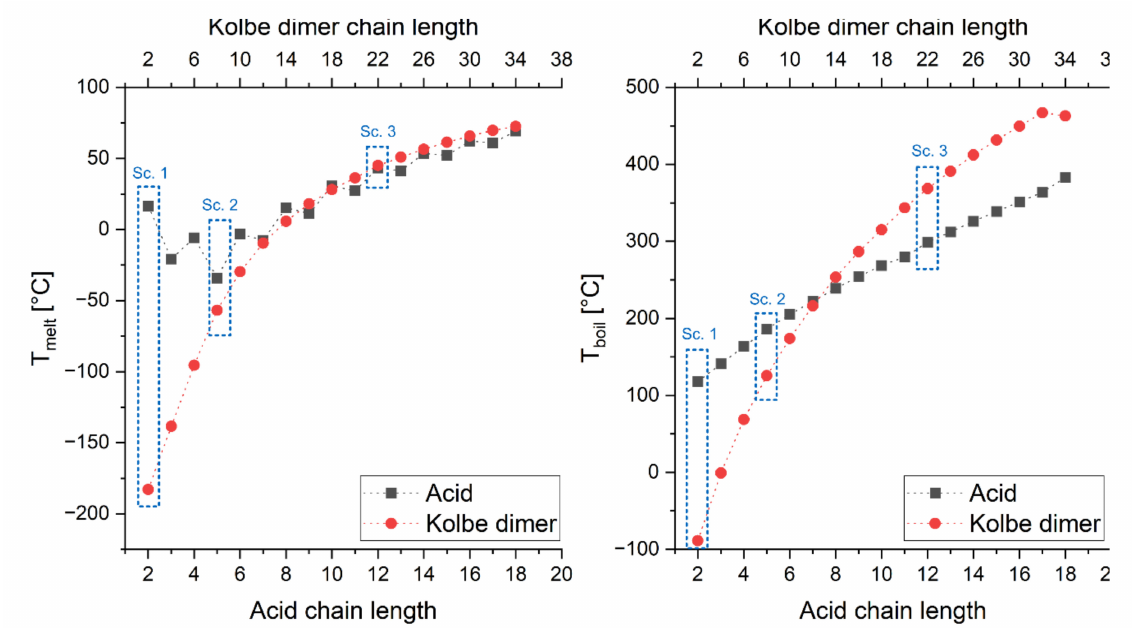
Figure 1. Melting and boiling point at ambient pressure of saturated fatty acids (FAs) and the Kolbe electrolysis products thereof; the lowers x-axis refers to the FA carbon chain length N and the upper x-axis refers to its corresponding Kolbe dimer chain length (2N − 2); Blue dashed boxes indicate the compounds of the three scenarios (Sc.) discussed in Section 3.3